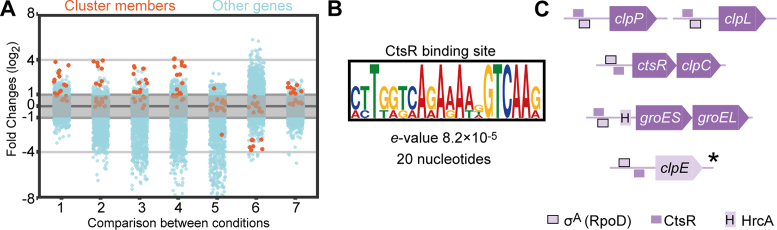
Temperature-responsive genes. (A) A cluster containing 19 genes was recovered from the clustering analysis based on the TPM values across 22 conditions. Comparisons were selected that demonstrate the fold change of cluster members (log2) in orange as compared to those of other genome-wide genes in light blue. Comparison 1 is CSFMC to FEVER; 2 is NMC to NMC » LMC; 3 is NMC to NMC » BMC; 4 is NMC to NMC » CSFMC; 5 is NMC to Trans, 5 min; 6 is C+Y to C+Y » NMC; and 7 is BMC to BMC » C+Y. (B) Motif enrichment analysis between 60 and 10 nts upstream of the transcription start sites of the six-membered operons resulted in a 20-nt wide CtsR-binding site, CTTGACHTTTTCTGACCAAG. (C) A genome-wide search for CtsR sites recovered four operons with a reported CtsR site that belonged to the original 19-gene cluster and one other gene, clpE. CtsR sites overlap with RpoD sites, and groESL expression is co-regulated by HrcA. *clpE is preceded by non-overlapping RpoD- and CtsR-binding sites.